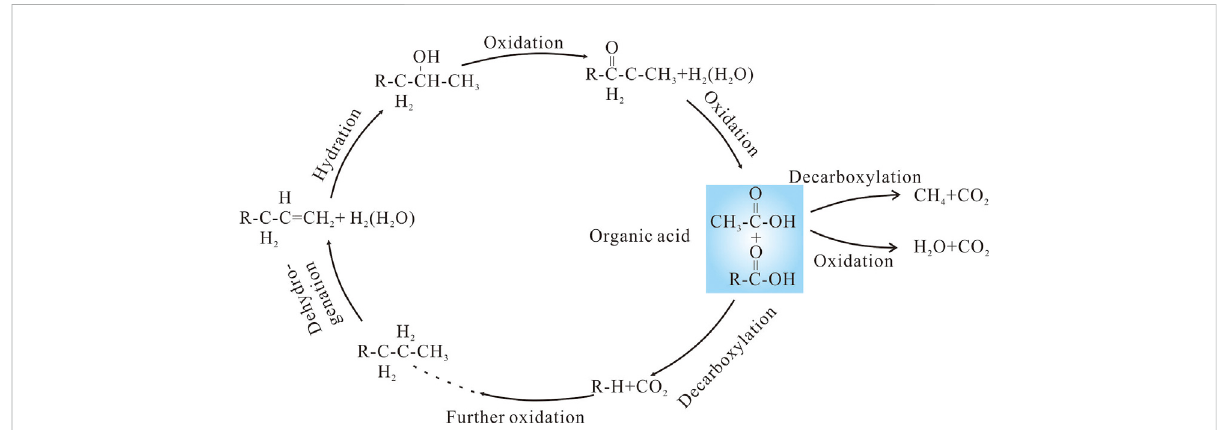
FIGURE 11 Reaction pathways for the oxidation of long-chain hydrocarbons alongside the reduction of high-valence Mn and Fe oxides. Modi fi ed after Seewald (2003).